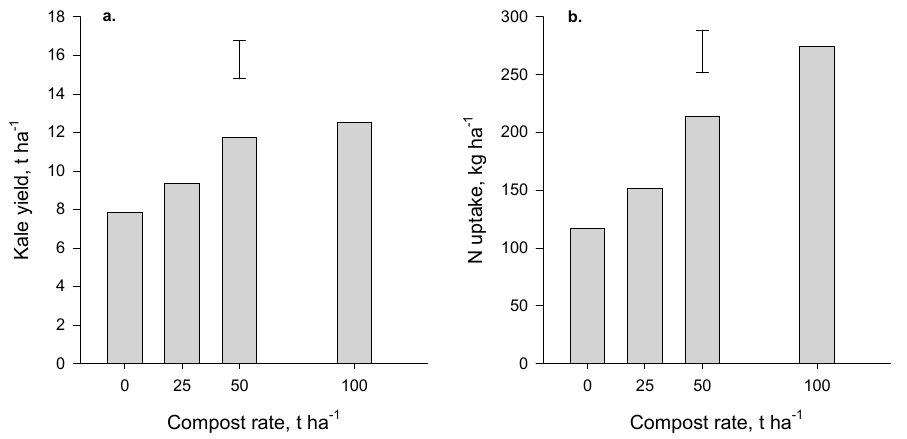
Figure 3. Effect of compost application rate on (a) dry matter yield and (b) N uptake by kale (the first crop grown in the Forage trial after compost application). Bars represent 5% LSD with 24 df .